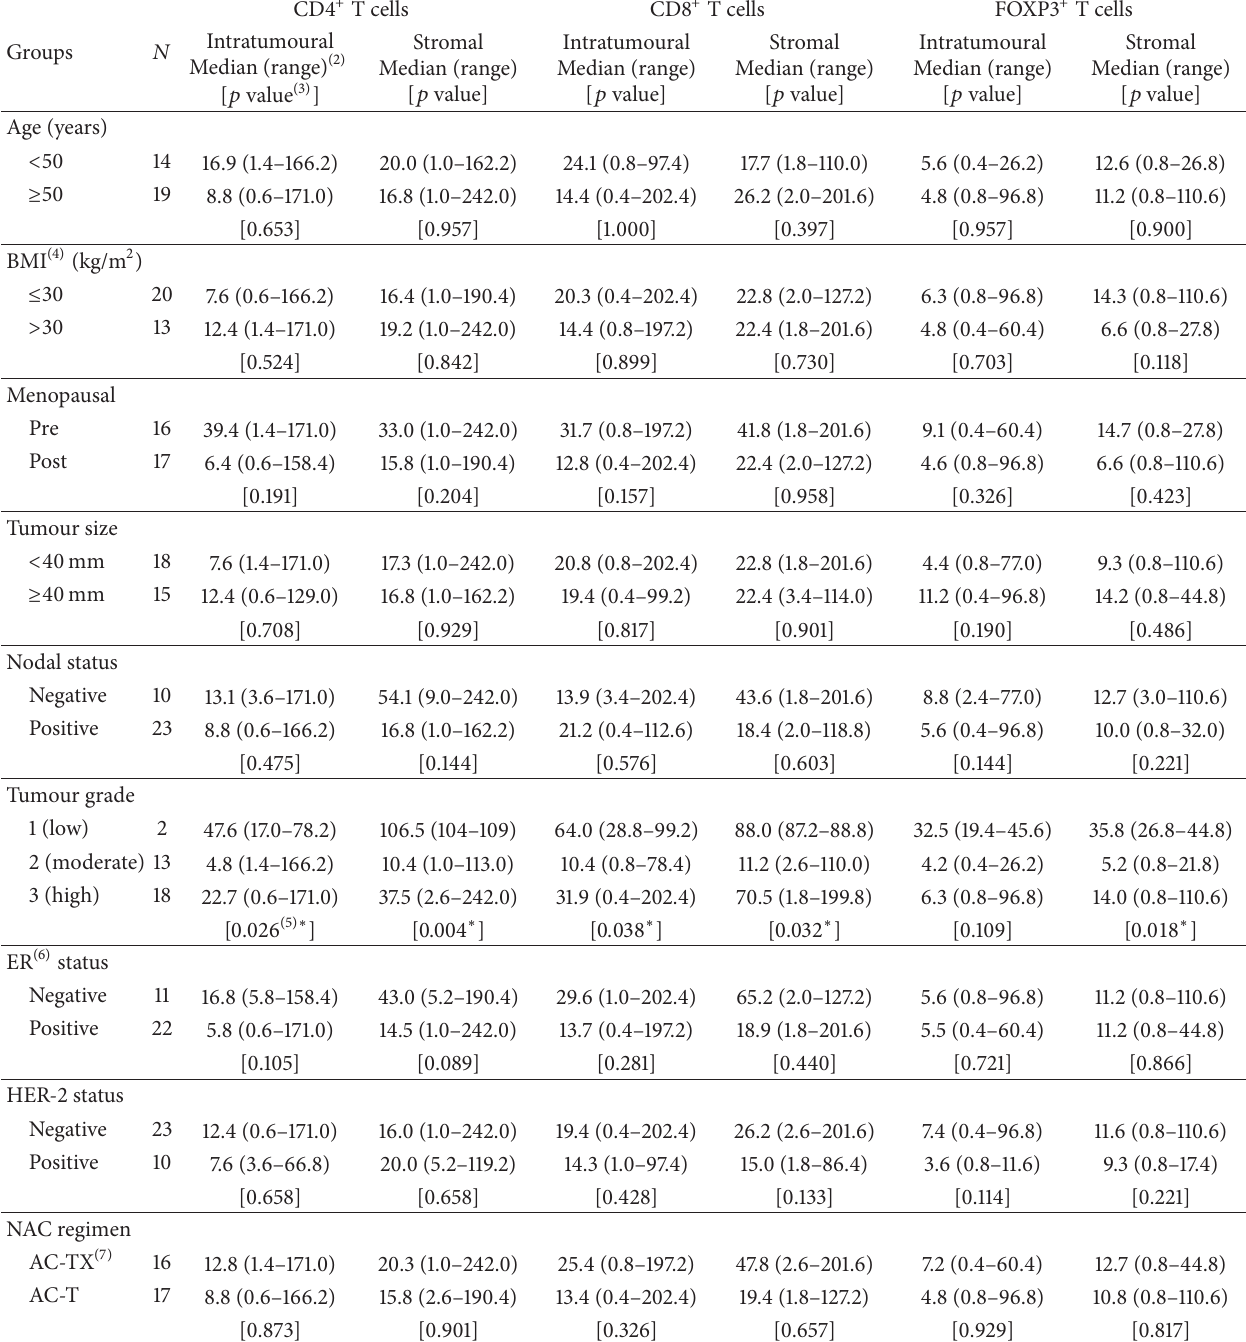
Table 9: Clinical and pathological parameters of patients ( 𝑛 = 33 ) studied and the presence of pre-NAC (1) tumour-infiltrating CD4 + and CD8 + and FOXP3 + T